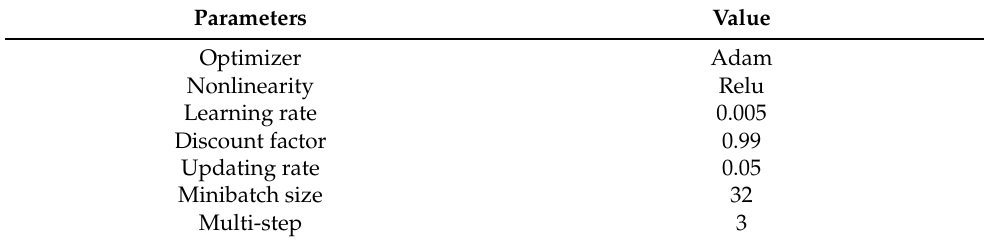
Table 5. Parameters of the graph reinforcement